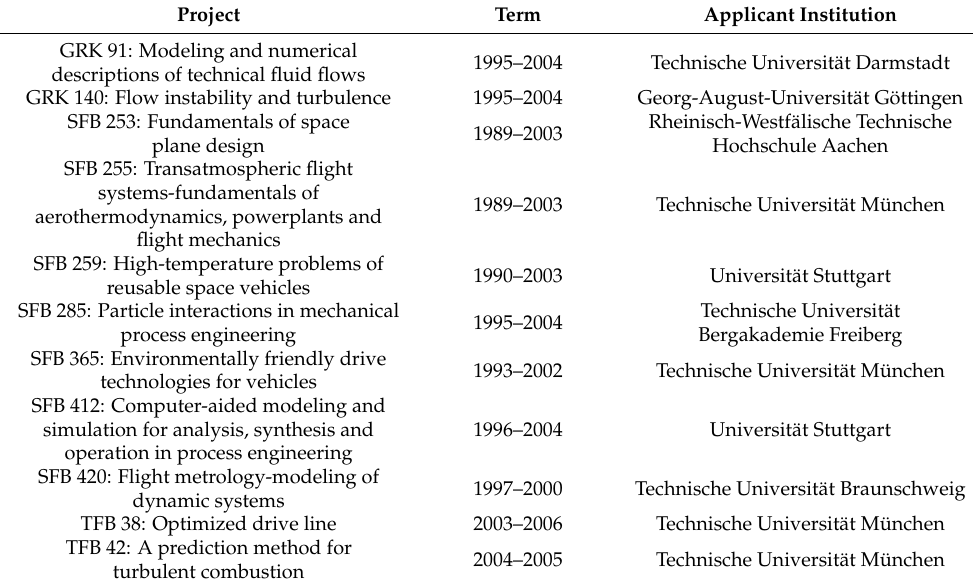
Abbreviations: SFB, Collaborative Research Centers; TFB, Transfer Units; GRK, Research Training